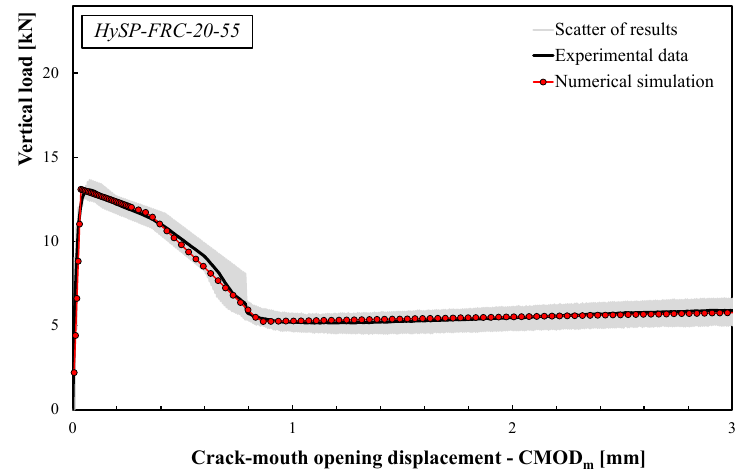
Figure 10. Experimental and numerical load–CMOD curves for the HySP-FRC-37.5 mixture.